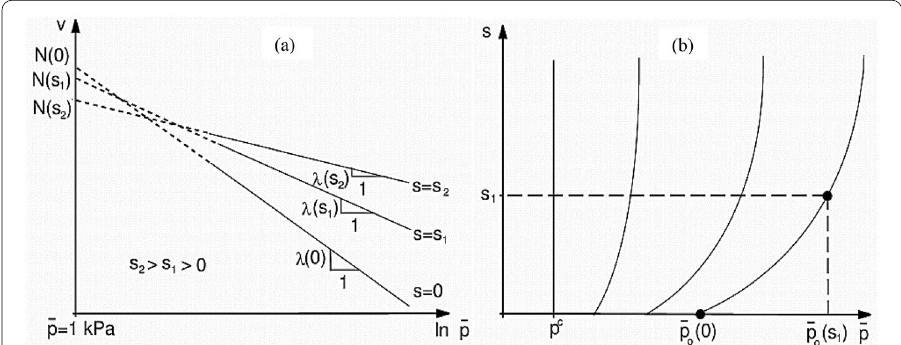
Fig. 1 a Post-yield compression curves at different values of suctions, b the shape of the LC yield curve in the p − s plane